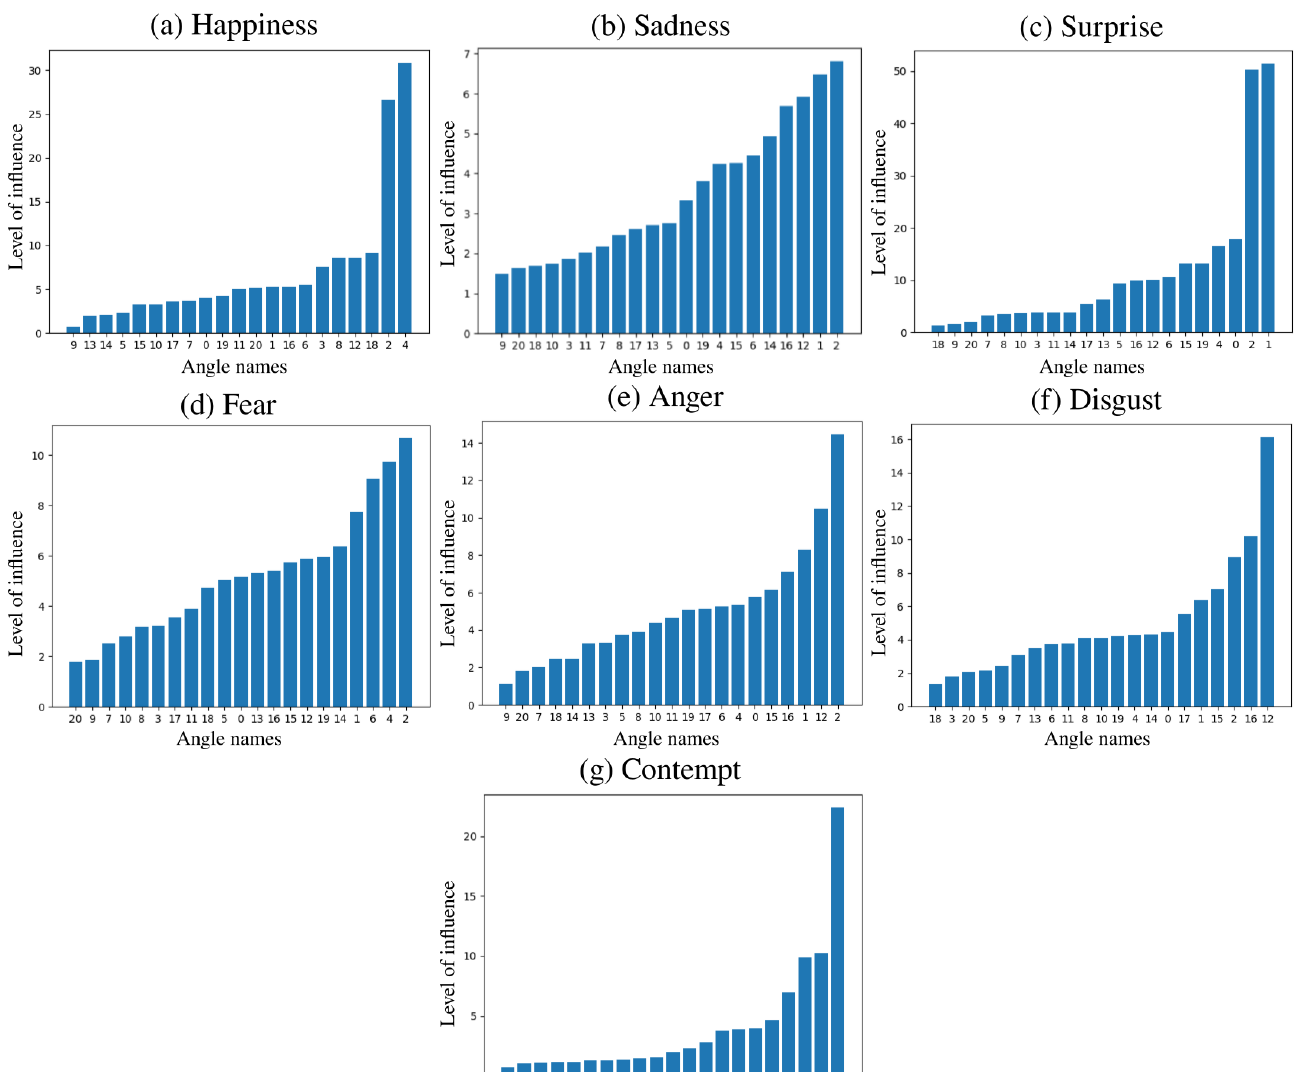
Figure 8. Study of the most influential angles for each